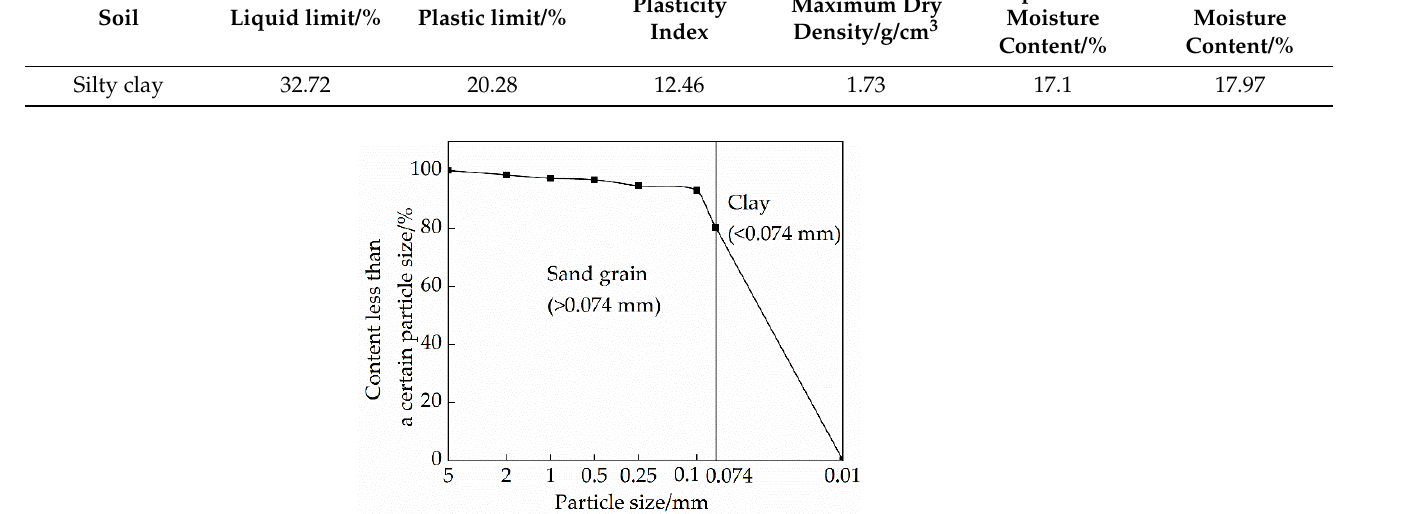
Figure 3. Particle size distribution of soil.